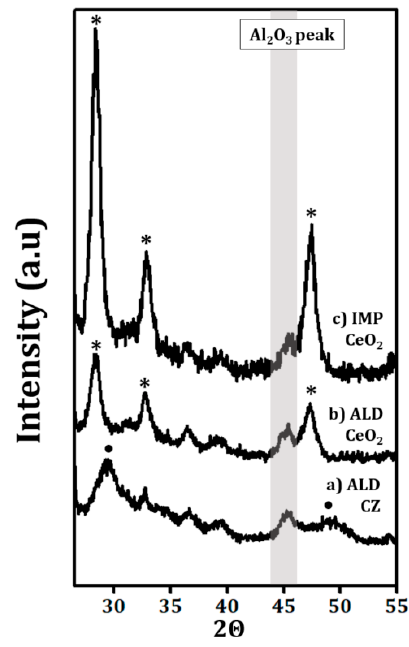
Figure 2. The CeO 2 (IMP)/ γ -Al 2 O 3 sample underwent three cycles of alternating reduction (90% H 2 and 10% H 2 O for 30 min) at 1073 K and oxidation (dry air for 30 min) at 1073 K. The two ALD-prepared samples were used for the thermodynamic measurements that will be discussed later in this paper and were exposed to many oxidation and reduction cycles over a period of several weeks, at temperatures between 873 and 1073 K. Redox cycling significantly narrowed and increased the intensity of the peak at approximately 28 degrees 2 θ on the CeO 2 (IMP)/ γ -Al 2 O 3 sample. Using the width at half height of the (220) diffraction peak, the ceria crystallite size on the CeO 2 (IMP)/ γ -Al 2 O 3 sample increased from 7 to 18 nm. Redox aging also caused changes in the XRD pattern for the CeO 2 (ALD)/ γ -Al 2 O 3 in that the fluorite phase now clearly evident, implying that the film had formed at least some crystallites. However, even after this harsh treatment, the CeO 2 crystallite size on the CeO 2 (ALD)/ γ -Al 2 O 3 sample was only 5 nm. Furthermore, the intensity of the CeO 2 diffraction peak remained much lower than that of even the fresh CeO 2 (IMP)/ γ -Al 2 O 3 sample. The CZ(ALD)/ γ -Al 2 O 3 sample also exhibited a weak peak that can be associated with a Ce 0.5 Zr 0.5 O 2 phase; but, again, this feature is weak in intensity and very broad.